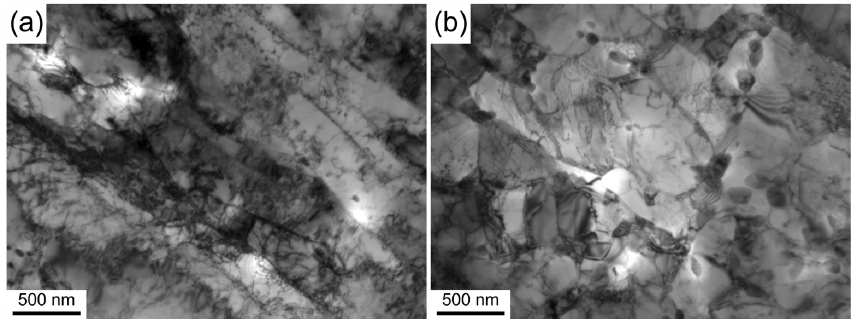
Figure 2. Transmission electron microscopy (TEM) micrographs of the T92 heat-resistant steel tempered at ( a ) 740 °C and ( b ) 790 °C.